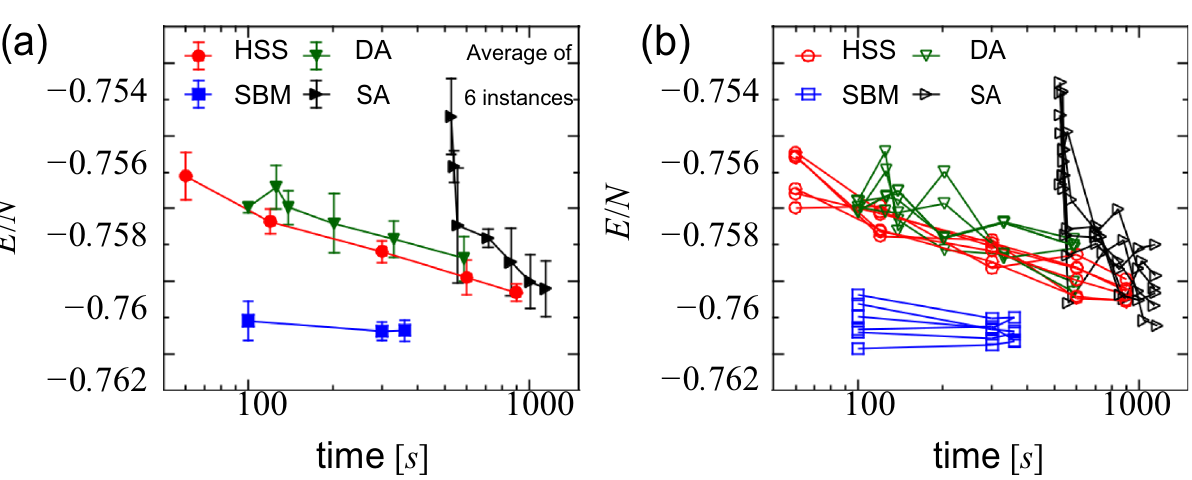
Figure 3. Value of cost function per variable as a function of the execution time, obtained for the SK model with a number of variables N = 8192 and J = 1. Each data point was obtained from an independent run. See the main text for the time metric of each solver. ( a ) Average of ten instances. The error bars denote standard deviation. For DA and SA, the execution time was also averaged. ( b ) Results for six different